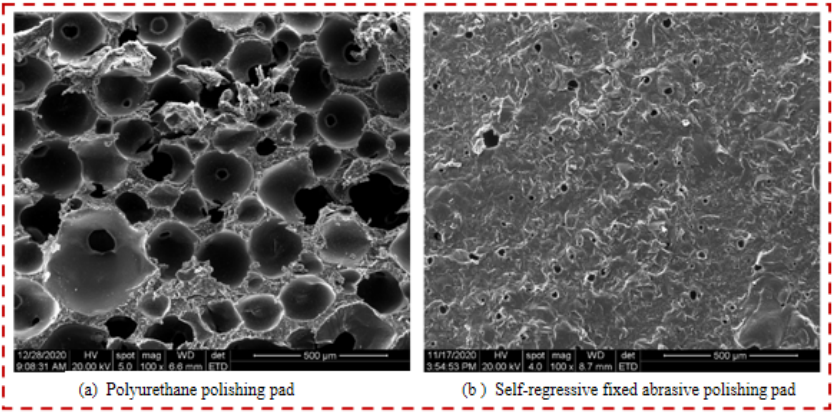
Figure 4. SEM images of the different polishing pad surface microstructures.